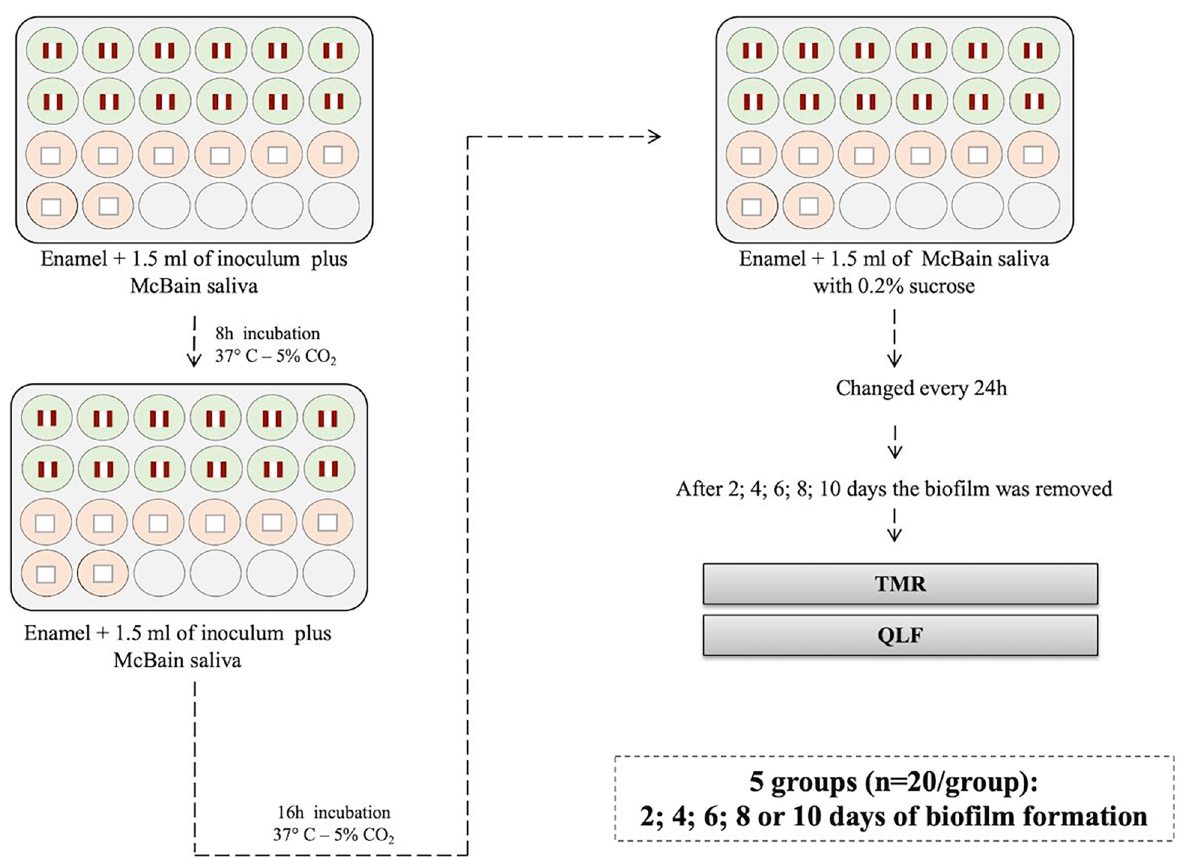
Figure 1- Experimental